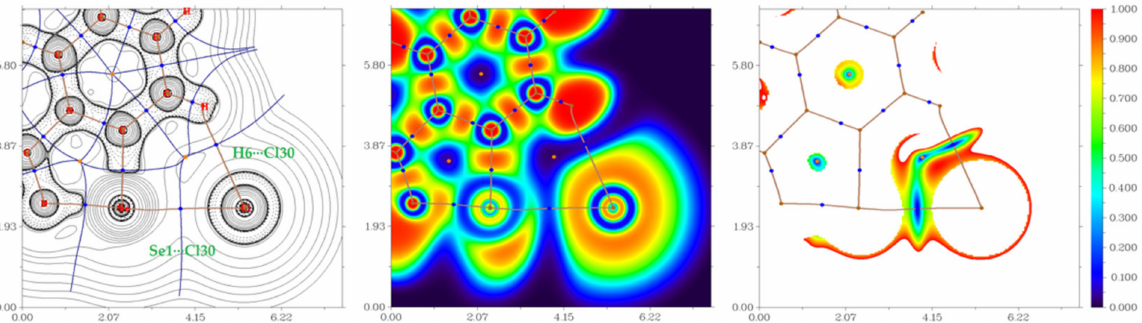
Figure 9. Contour line diagram of the Laplacian of electron density distribution ∇ 2 ρ ( r ), bond paths, and selected zero-flux surfaces (left panel), and visualization of electron localization function (ELF, center panel) and reduced density gradient (RDG, right panel) analyses for non-covalent interactions H6 ··· Cl30 and Se1 ··· Cl30 in the model supramolecular associate 4 . Bond critical points (3, − 1) are shown in blue, nuclear critical points (3, − 3) in pale brown, ring critical points in orange. Bond paths are shown as pale brown lines, length units are in Å, and the color scale for the ELF and RDG maps is presented in a.u. The numeration of atoms corresponds to their ordering in the attached xyz-files for model supramolecular associates (Supplementary